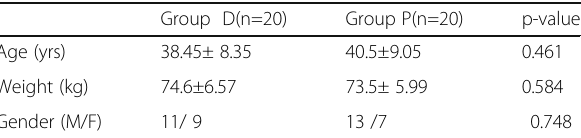
Table 1 Patient ’ s